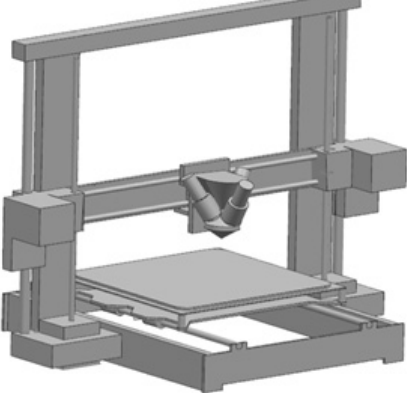
Figure 10. The improved color 3D printer.